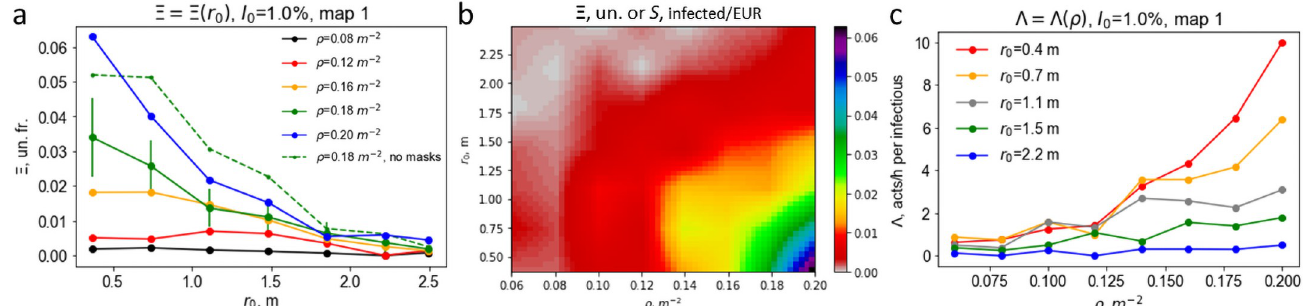
Fig 5. Kinetics of the infection spread in a supermarket. (a) Probability to get infected X as a function of social distance r 0 for different customer densities. Full lines—half of the customers wear medical masks; dashed line—the masks are lacking. Error bars, shown for ρ = 0.18 m − 2 , indicate a typical simulation accuracy. (b) Two-dimensional diagram for the probability to get infected X versus r 0 and ρ . It coincides with the diagram for the social price S ( r 0 , ρ ) for the unit profit coefficient, a = 1 EUR. For other values of a a linear re-scaling is applied (for more explanation see the text). (c) The infection spread rate Λ as a function of ρ for different r 0